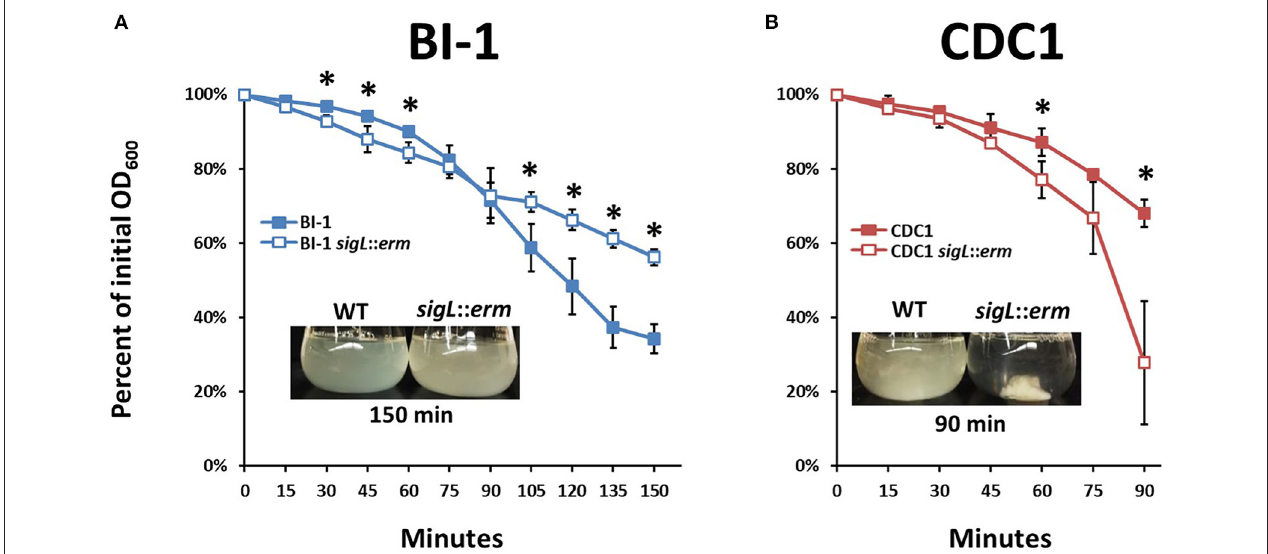
FIGURE 4 | Autolysis rates of C. difficile strains and sigL mutants differ between BI-1 and CDC1. Cultures were grown to OD 600 level of approximately 1.2, and OD 600 values were measured as percent of initial OD over time following the addition of Triton X-100. Visualization of autolysis in (A) . BI-1 and (B) . CDC1 compared to respective sigL::erm mutants are show as insets. Each assay was performed in biological triplicate. * p < 0.05.